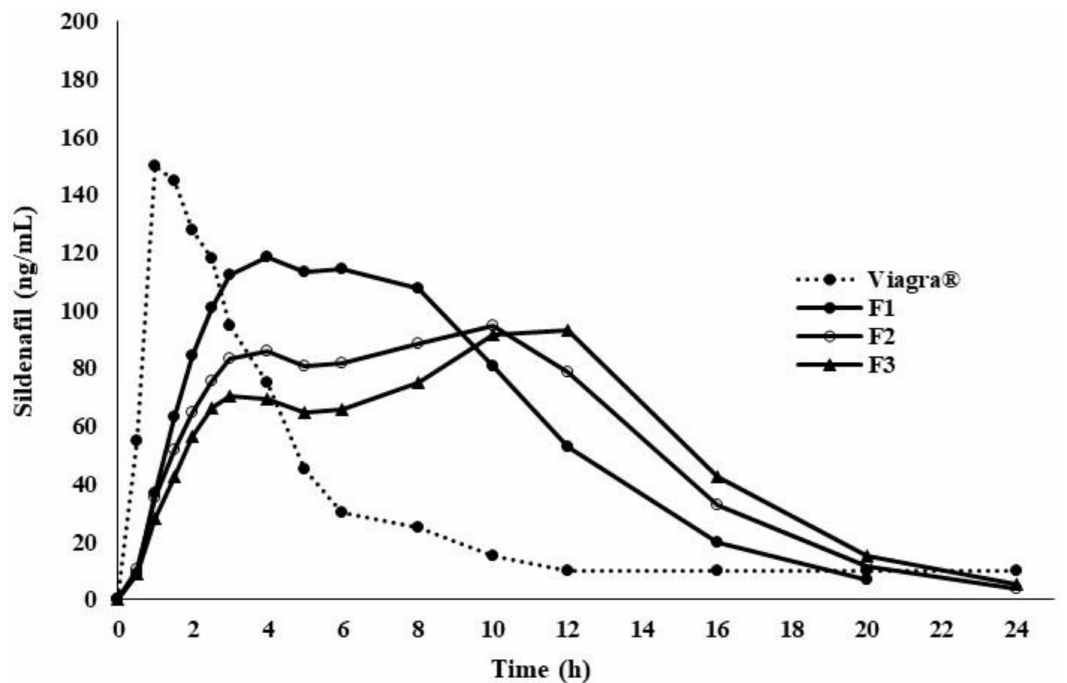
Figure 4. Simulated plasma concentration–time profiles of sildenafil oral controlled release polymer matrices formulation (F1–F3) versus Viagra ® 50 mg using Gastroplus™ PBPK modeling